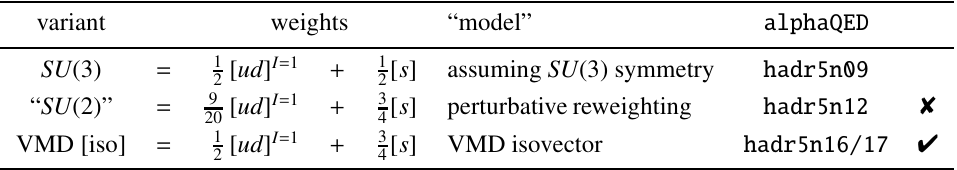
3 γ in terms of h i “ SU (2)” [31,